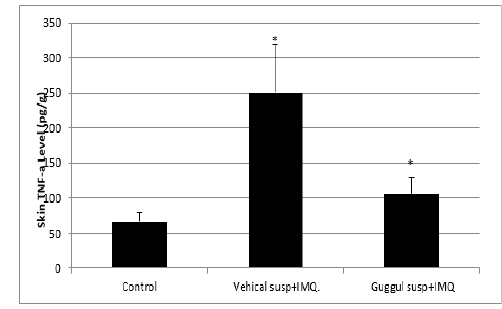
Figure 7. Effect of oral administration of guggulsterone on tissue TNF- α level in imiquimod - induced psoriasis in mice. - Each value represents mean ± standard deviation (SD). - *= Significantly different ( P <0.05) with respect to the negative control group. - # P<0.05% significant in comparison with vehicle susp+IMQ group. right ear section.